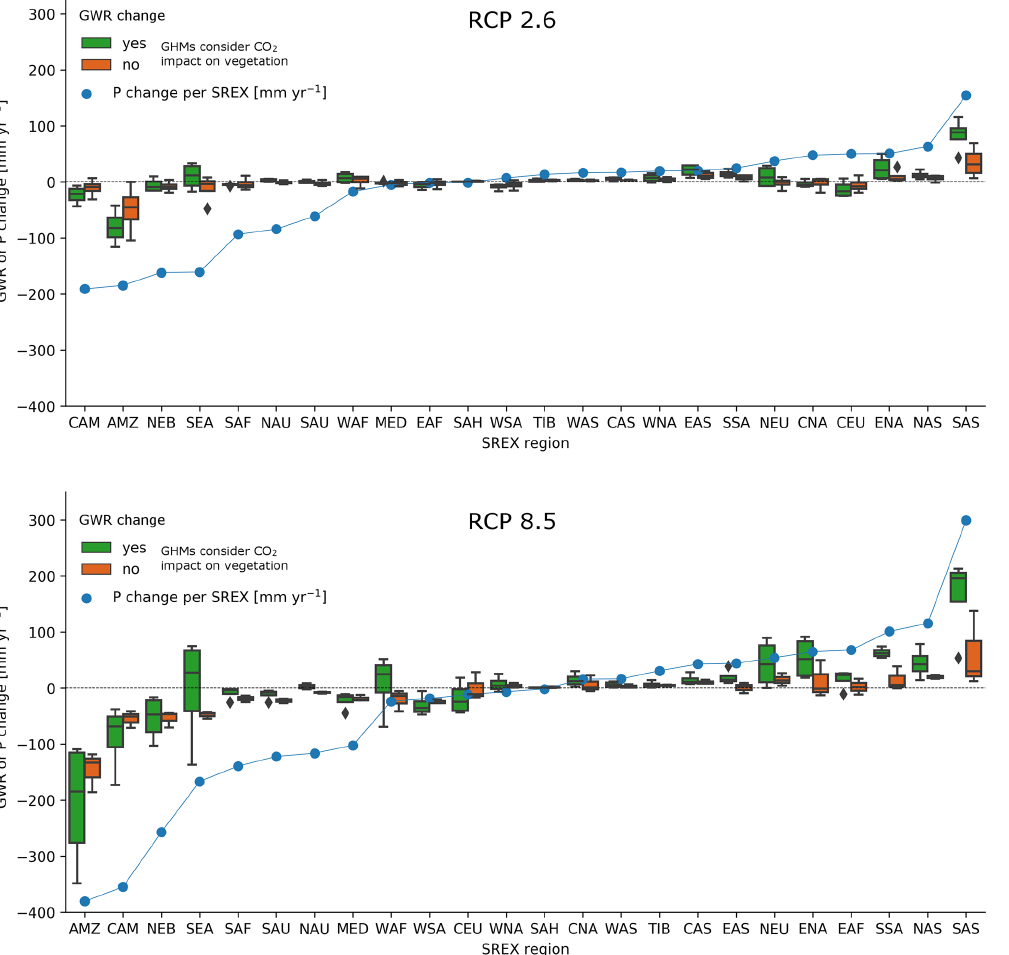
Figure 7. Relation of changes in precipitation ( P ; means from 1981–2010 to 2070–2099) to changes in GWR (means from 1981–2010 to 2070–2099), depending on the model type (with or without CO 2 ; see also Table 1) per SREX (selection as in Table 3) for RCP2.6 and RCP8.5 for the GCM